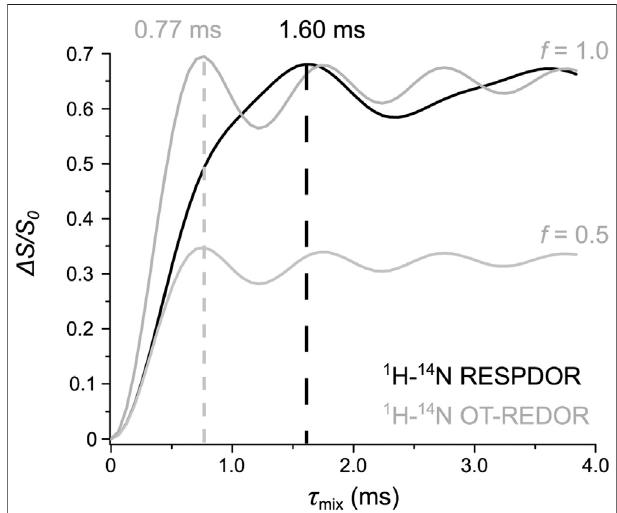
FIGURE 4 | Comparison between the universal curves of 1 H- 14 N RESPDOR (black) and 1 H- 14 N OT-REDOR (grey) with f (cid:1) 0.5 (complete saturation) and 1.0 (complete inversion) derived from Eqs 2,3 , respectively, underthe same 1 H- 14 Ndipolar coupling of2.0 kHz.Theoptimum τ mix of both curves are shown and highlighted by the dashed lines.